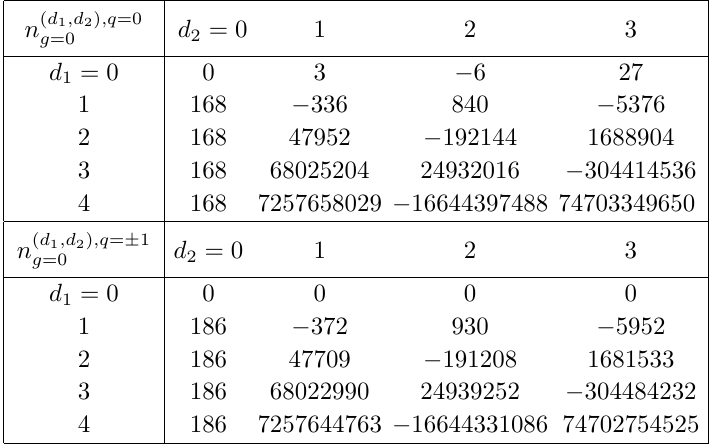
Table 5 . Z 3 -refined genus 0 GV-invariants with Z 3 charge q ∈ { 0 , ± 1 } associated to X (1)